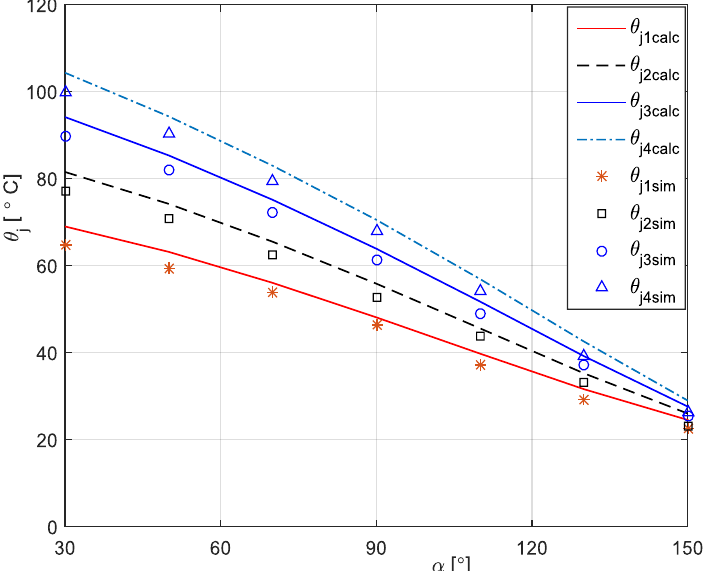
Figure 11. Junction temperature variation vs. firing angle at different current values of 200, 250, 300, and 340 A ( v air = 3 m/s; R = 3 Ω; L = 30 mH).